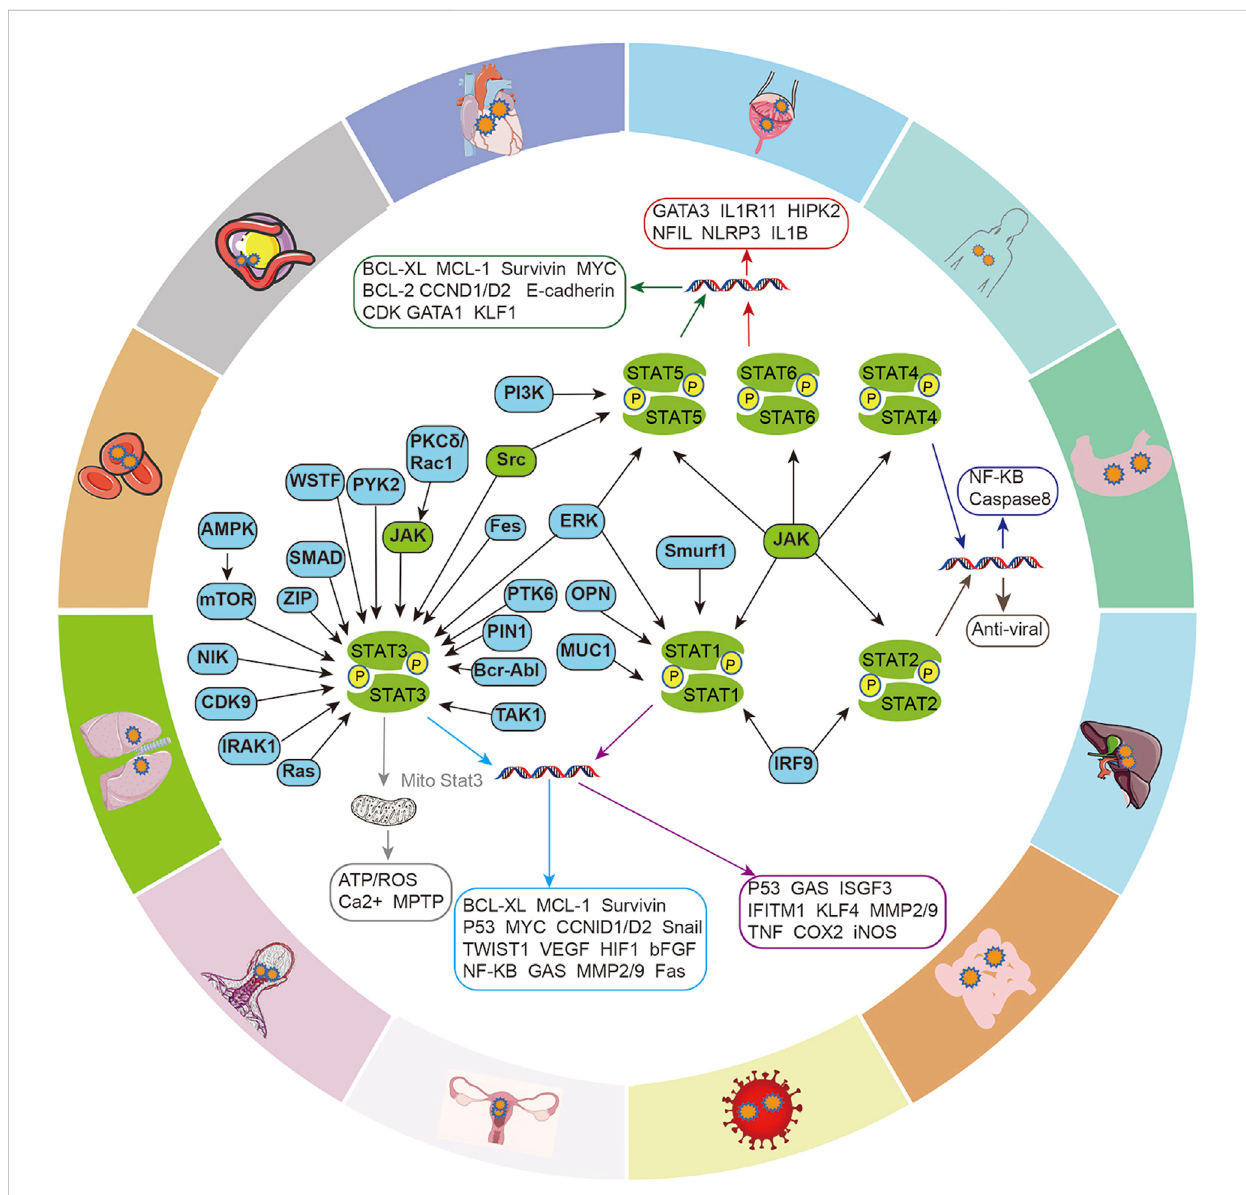
FIGURE 2 Intracellular signaling crosstalk of the JAK/STAT pathway. Different signaling proteins activate different STATs and induce the transcription and expression of genes for different cellular functions, including cell cycle, apoptosis, cell proliferation, epithelial-mesenchymal transition (EMT), angiogenesis, in fl ammatory factor production, etc. which in turn are involved in the development of various